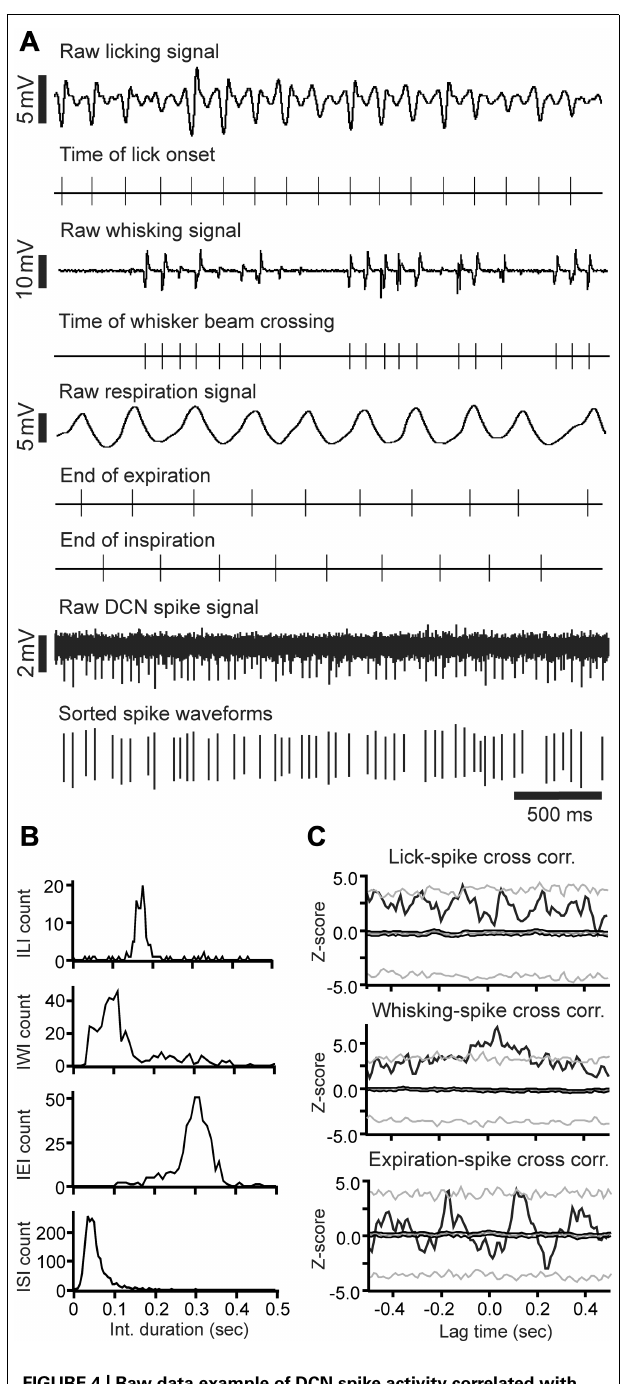
FIGURE 4 | Raw data example of DCN spike activity correlated with licking, whisking and respiratory behavior. (A) Raw data examples of single-unit DCN spike activity with licking, whisking and respiratory behavior. Under each trace are time markers marking the tongue-to-spout contact times for the licking trace, the time of whisker beam crossing for whisking trace, the end-of-expiration and inspiration times for the respiratory trace, and spike activity for the DCN spike train recording, respectively. (B) Histograms showing the inter-lick interval, inter-whisking interval, inter-expiration interval, and inter-spike interval distribution. (C) Histograms showing the cross-correlation between DCN spikes with licking, whisking, and expiration events.